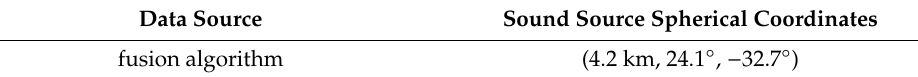
Figure 10. Radar chart displayed at 20:10. Table 7. First experimental results.